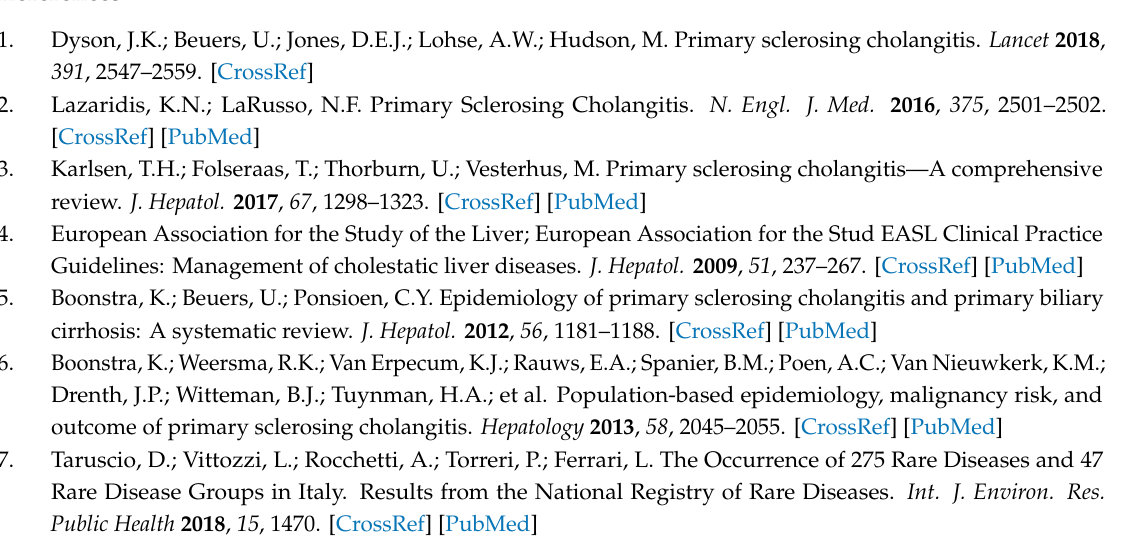
Figure S1: Data flow within the italian National Rare Diseases Registry, Table S1: Regional distribution of incident cases with primary sclerosing cholangitis and incidence rate per 100,000 individuals during 2012–2014 in Italy., Table S2: Characteristics of 25 individuals with primary sclerosing cholangitis who had